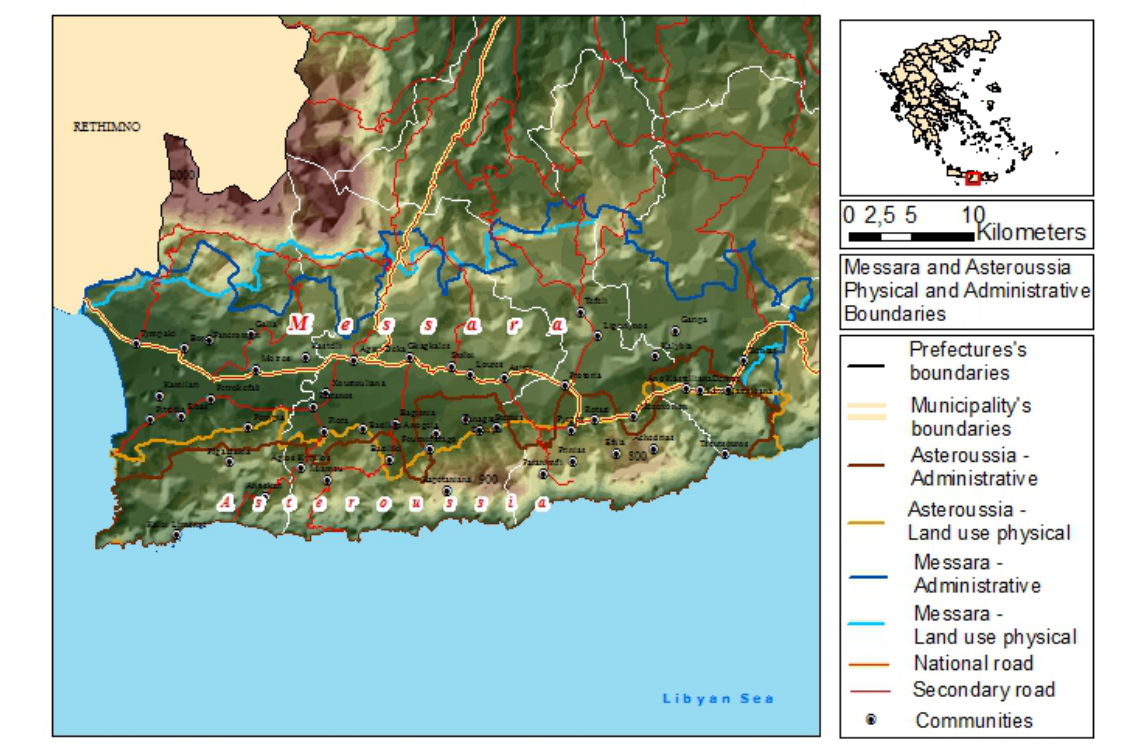
Fig. 1 . Physical and administrative limits of Asteroussia